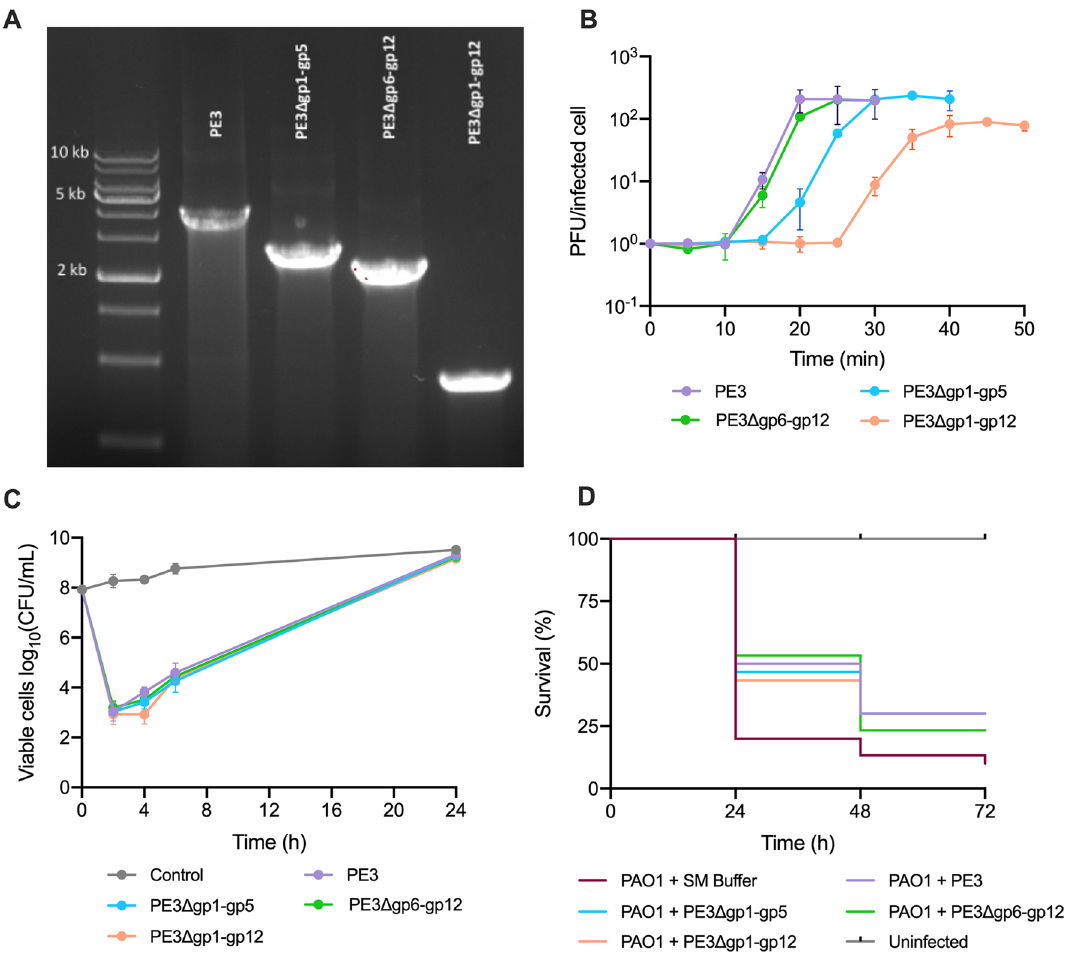
Figure 3. Wild-type phage versus synthetic phages. ( A ) PCR-based confirmation of the deletions in the genome of phage PE3. ( B ) One-step growth curves of wild-type (PE3) and synthetic phages phages (PE3Δgp1–gp5, PE3Δgp6–gp12 and PE3Δgp1–gp12). ( C ) Treatment of P. aeruginosa PAO1 log-phase cultures with the wild- type phage or synthetic phages using a MOI of ~ 5. No phage was added in the control. Error bars represent SD from three independent experiments. ( D ) G. mellonella larvae were injected with either PBS (uninfected group) or P. aeruginosa PAO1 followed by a subsequent administration of wild-type or synthetic phages at a MOI of ~ 100 or SM Buffer in the non-treated group. Survival curves represent three independent experiments, each with 10 larvae per treatment